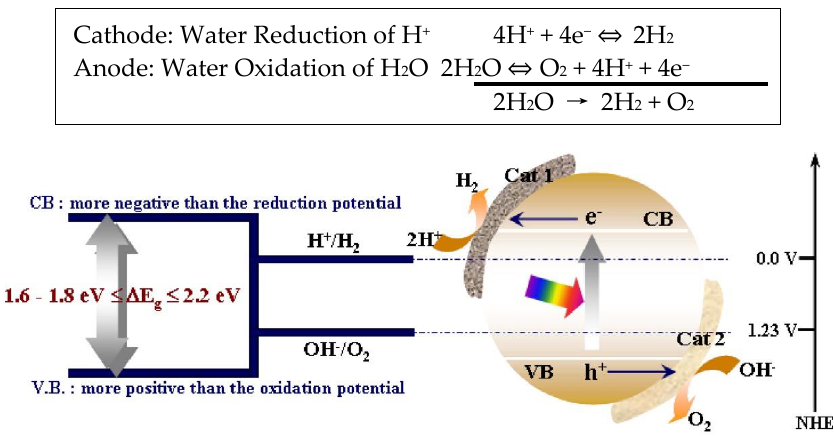
Figure 2. Principle of photocatalytic water-splitting (PC) reactions [7]. Copyright 2014, Elsevier.